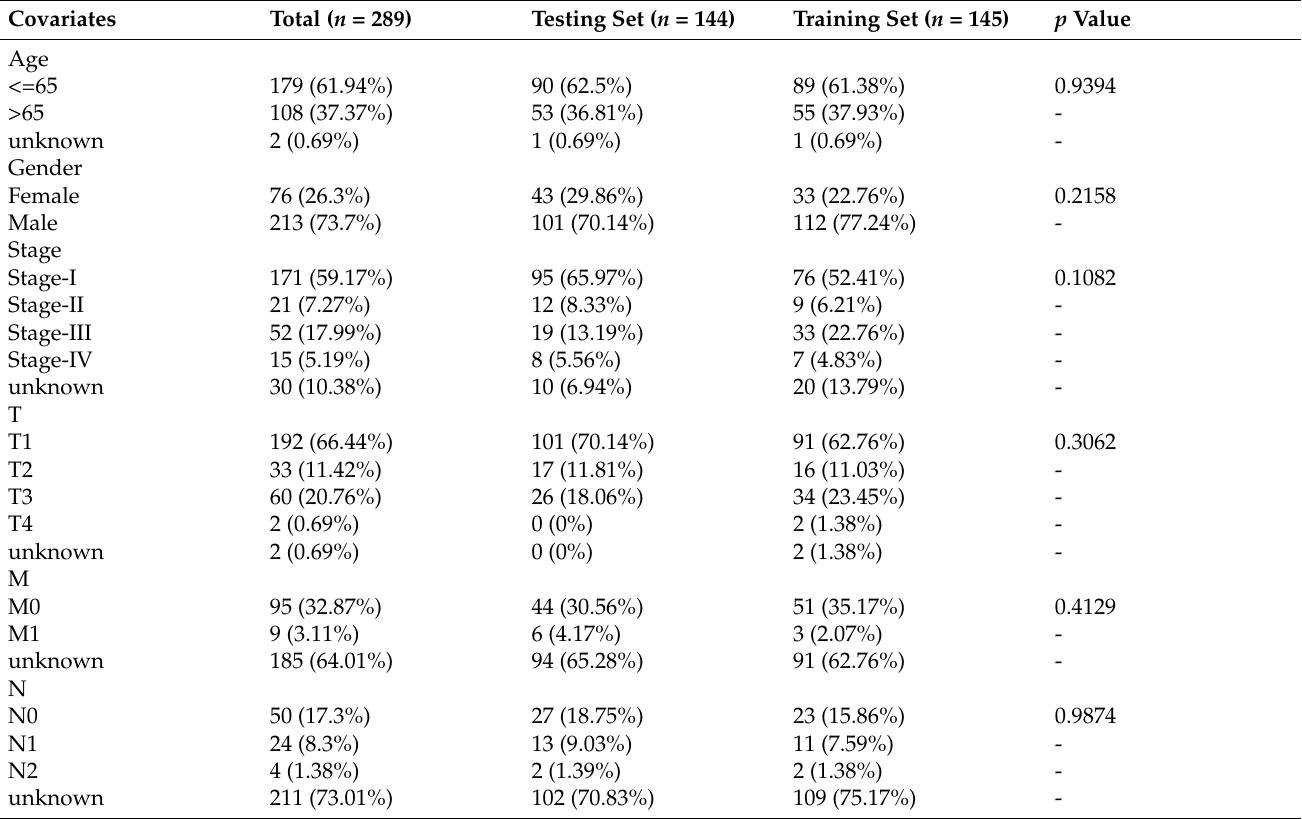
Table 1. The clinical features of pRCC patients who were trained and